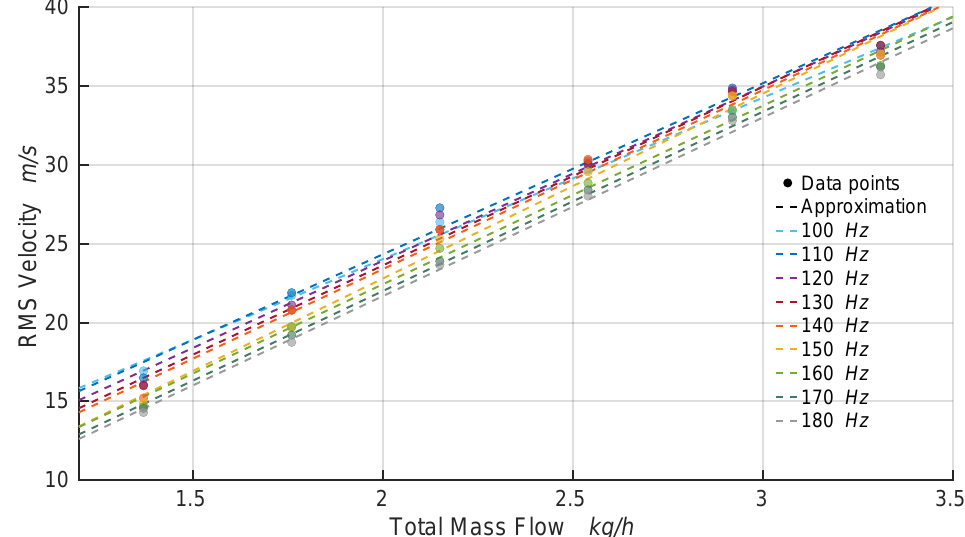
Figure 7. Linear fit between RMS velocity and total mass flow. The approximation was achieved by fitting the linear function to the measured data